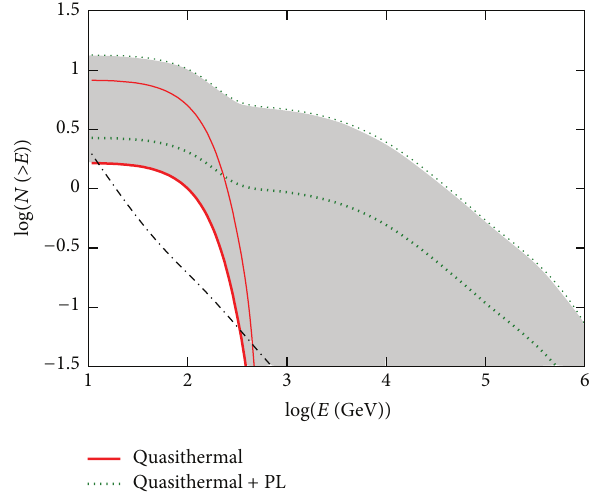
Figure 1: The expected number of subphotospheric ] 𝜇 + ] 𝜇 for 3250 GRB stacking analyses with DeepCore + IceCube from Murase et al.